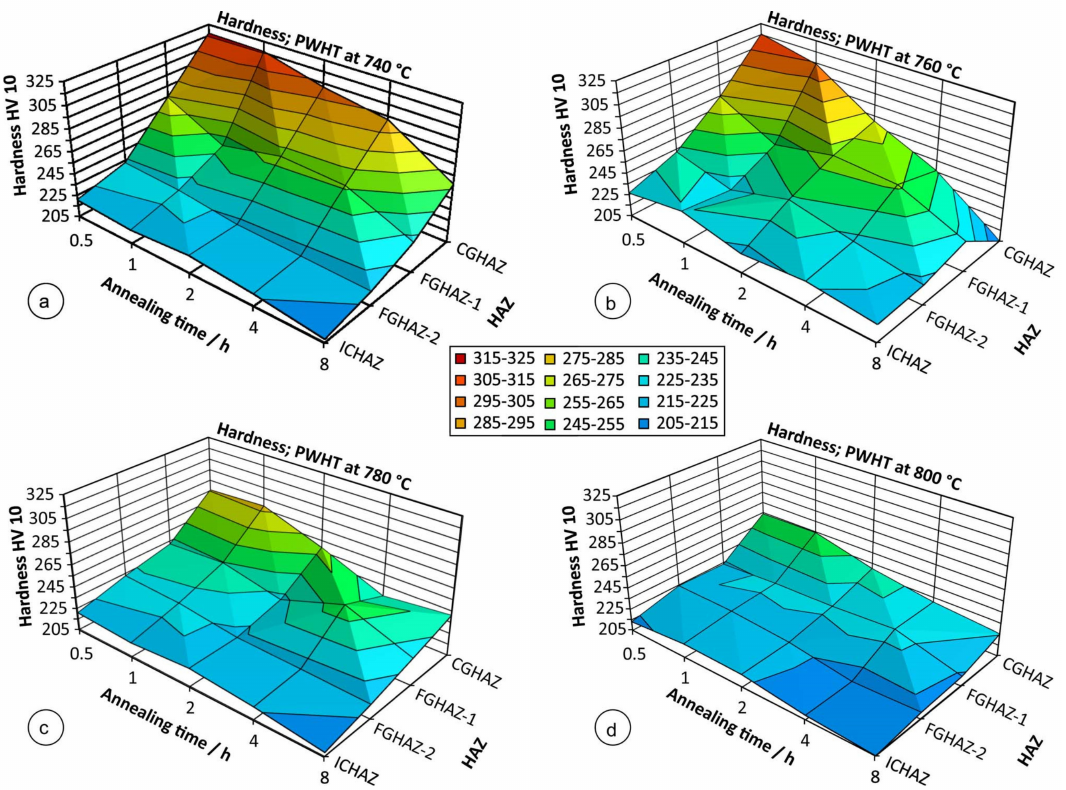
Figure 5. Hardness after PWHT at ( a ) 740 ◦ C; ( b ) 760 ◦ C; ( c ) 780 ◦ C and ( d ) 800 ◦